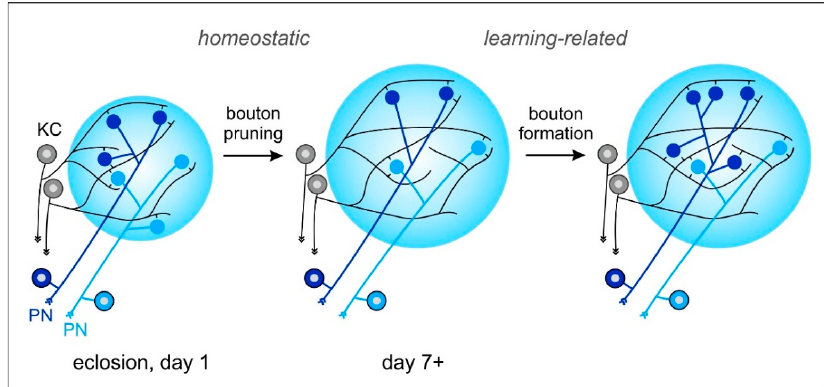
Figure 3. Model of dynamic changes in projection neuron (PN) to Kenyon cell (KC) synaptic connections in the MB-calyx microglomeruli (MG) following non-associative and associative sensory experiences. (Left) Initial number of PN boutons (blue, light blue) in the MB calyx after emergence into adult life. (Middle) Sensory exposure-dependent pruning of PN boutons. At the same time, KC (grey) dendrites expand their network and extend spines to various PN boutons. MG reorganization after increased sensory exposure may be an important preparation of the MB microcircuits for subsequent associative learning and memory formation. (Right) An increase in MG numbers occurs after formation of a transcription-dependent stable long-term memory (LTM) following associative learning. PN: projection neuron; KC: Kenyon cell. See text for further details and references to the original